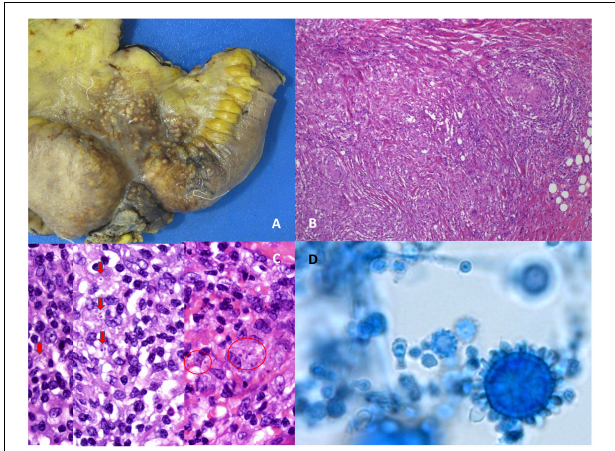
FIGURE 1 | Morphological appearance of Histoplasma capsulatum var. capsulatum in culture and in affected tissues. Images (A–C) are courtesy of Dr. Steffania Landolfi. (A) Surgically excised ileum showing stenosis and multiple macroscopic nodules from a case of disseminated histoplasmosis with intestinal involvement. (B) Tipical appearance of granulomas in tissue, hematoxilin-Eosin. (C) Intracellular yeasts surrounded by a clear area resembling a pseudocapsula (Hematoxilin-Eosin staining). (D) Tuberculate macroconidia of Histoplasma capsulatum var. capsulatum in